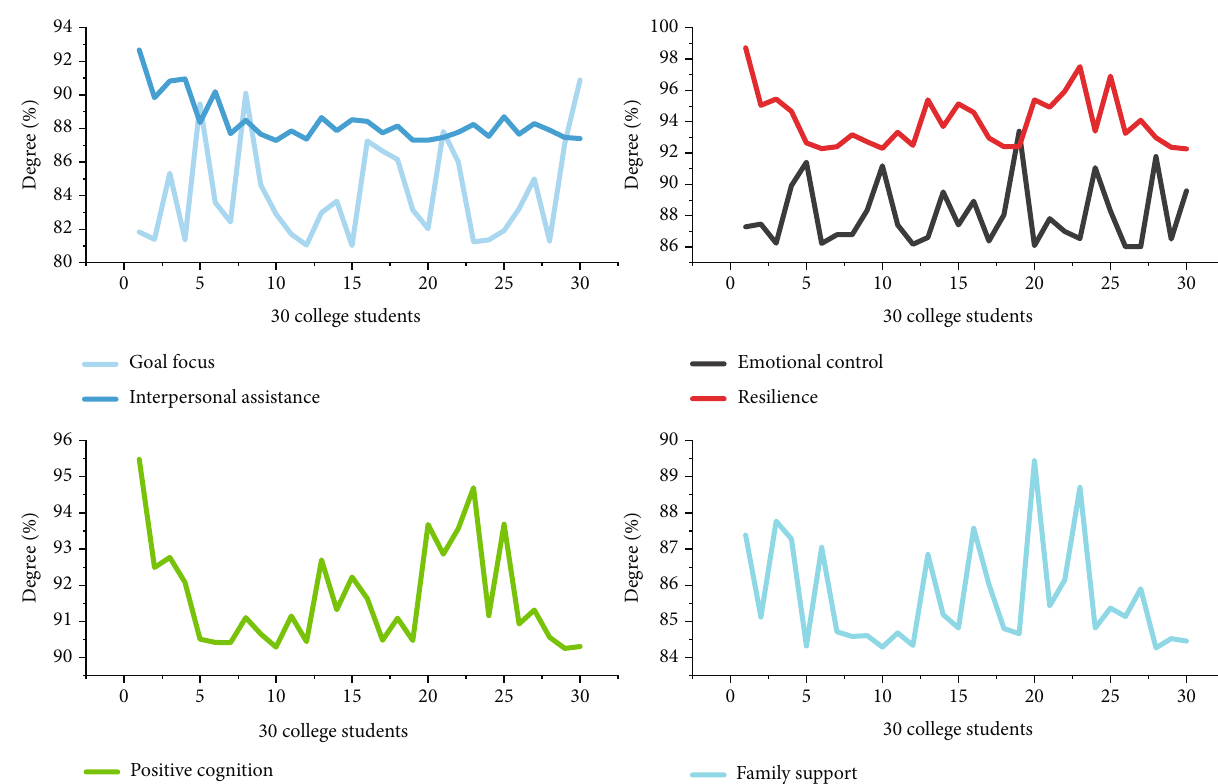
Figure 3: The goal focus, emotional control, positive cognition, family support, interpersonal assistance, and resilience of 30 college